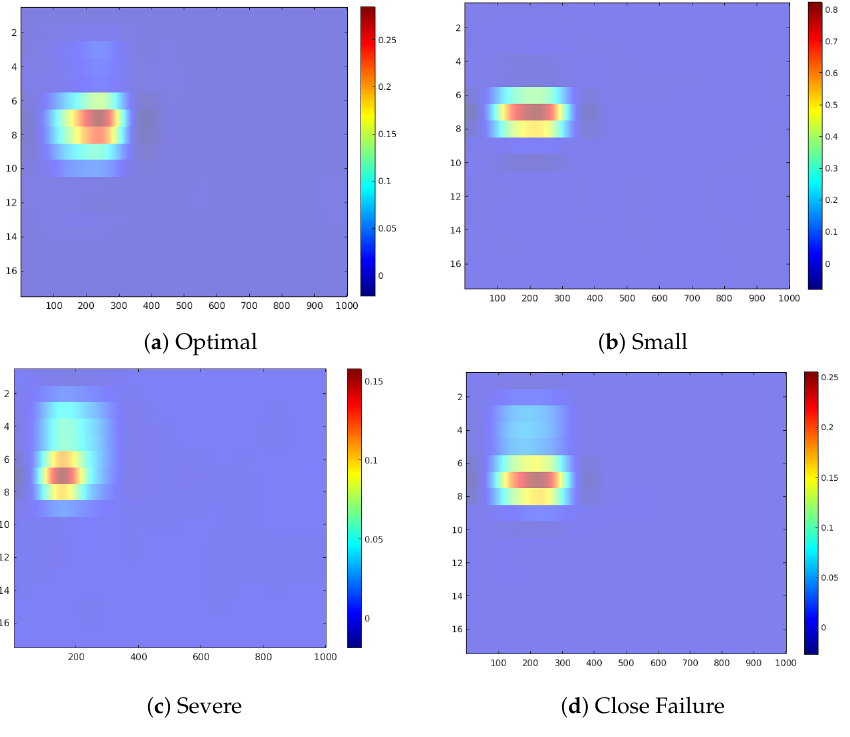
Figure 5. Feature attribution heatmap for the Valve condition.